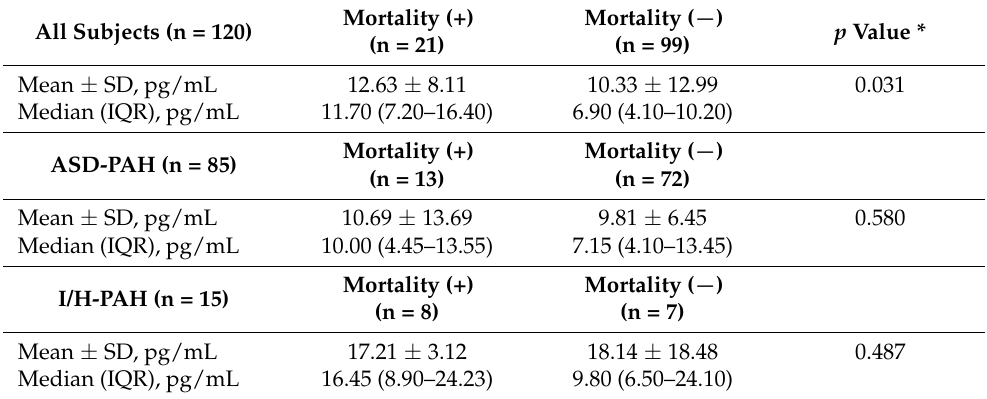
Table 4. The plasma levels of bio-ADM in association with mortality in all subjects, ASD-PAH subjects and I/H-PAH